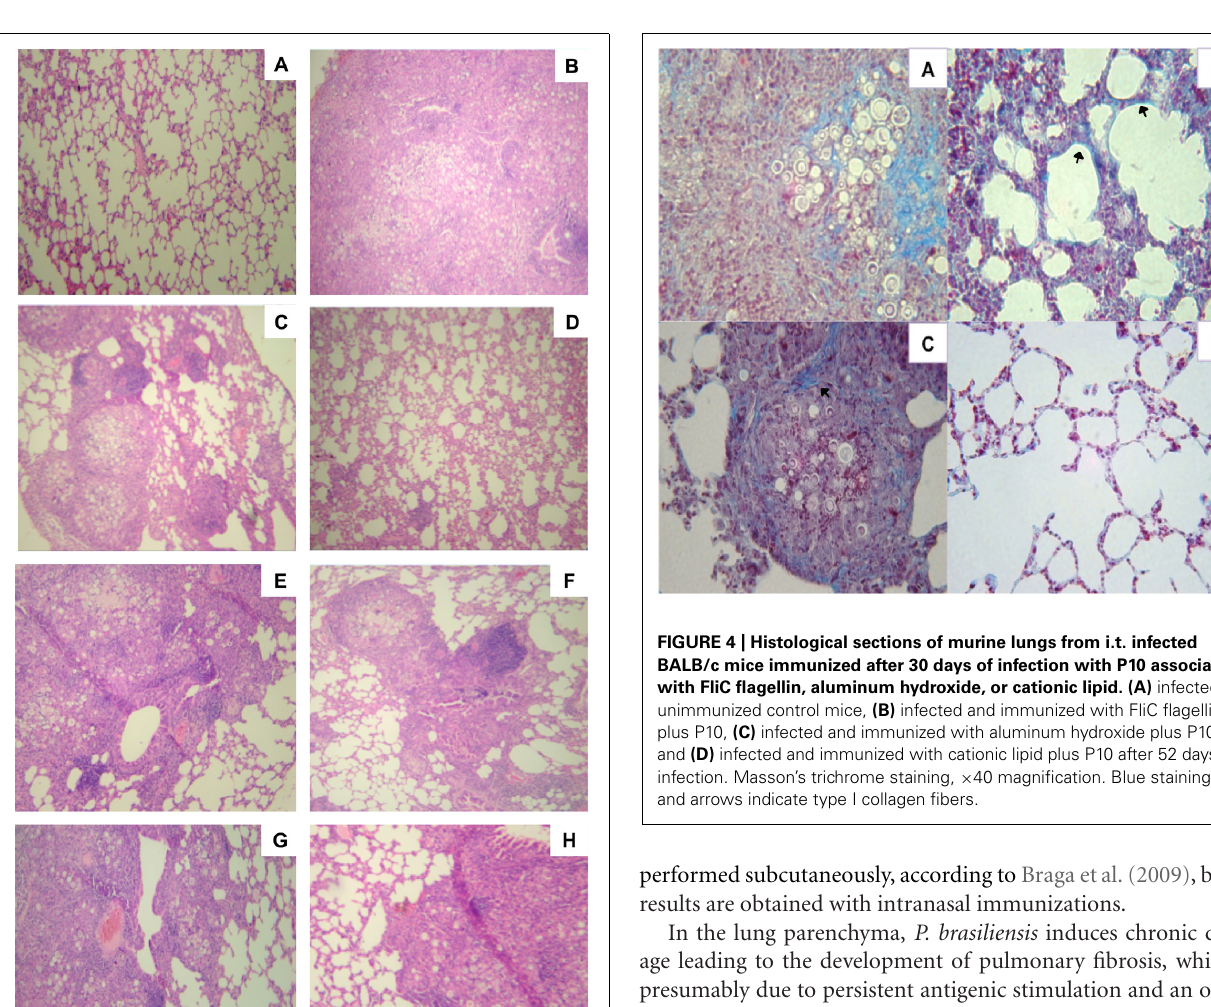
performed subcutaneously, according to Braga et al. (2009), better results are obtained with intranasal